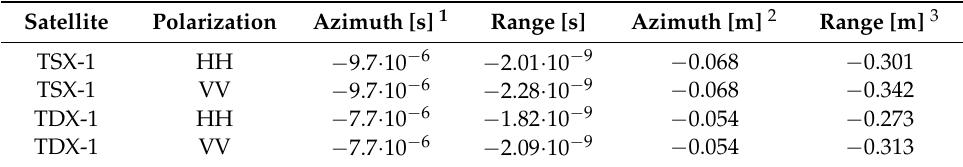
Table 3. Applied geometric calibration constants in seconds and converted to spatial distances.